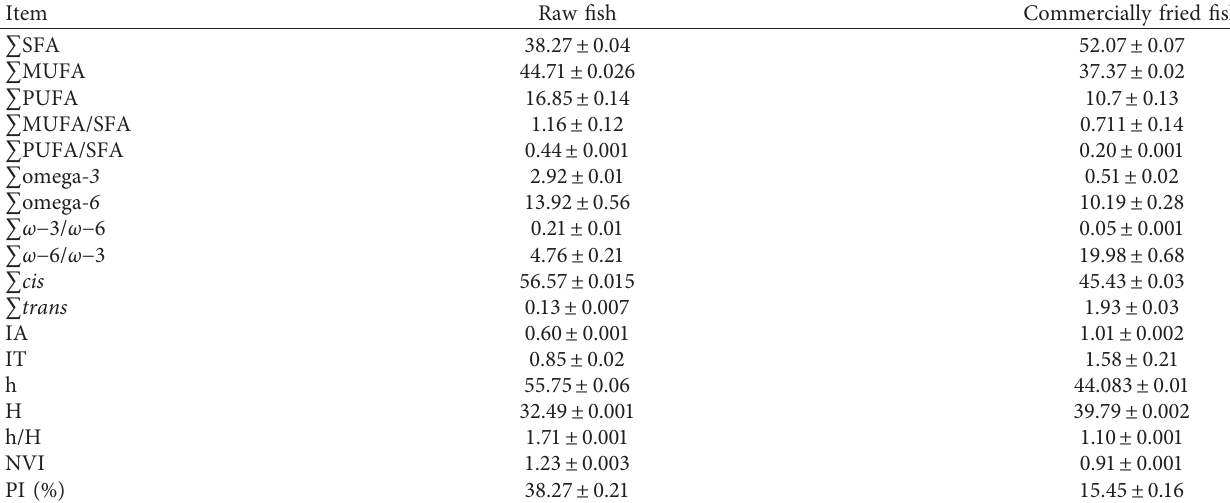
Table 3: Nutritional quality indices of lipids in raw and commercial fried fish.